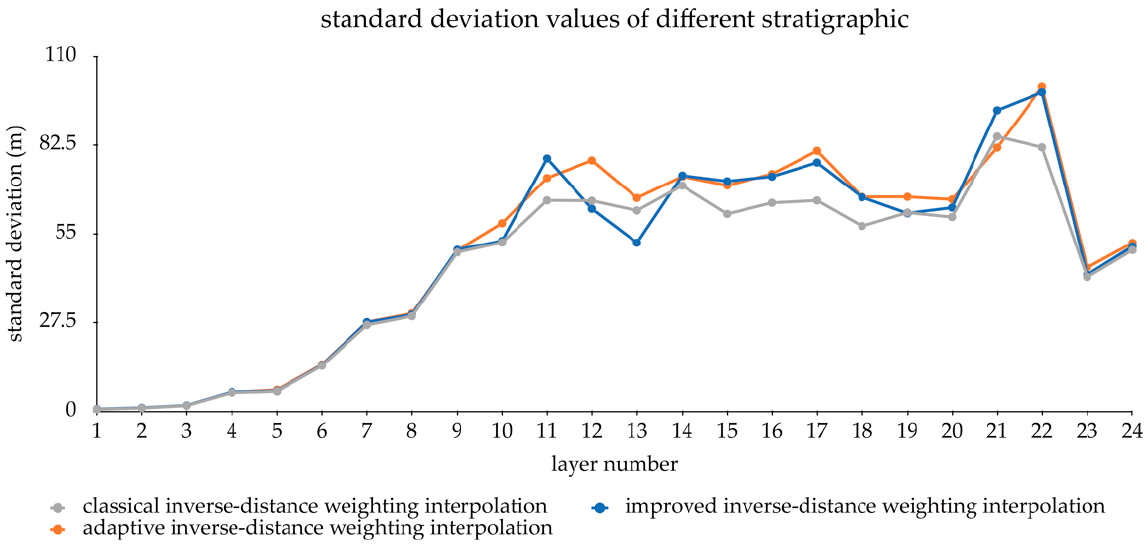
Figure 14. Standard deviation of different stratigraphic properties.